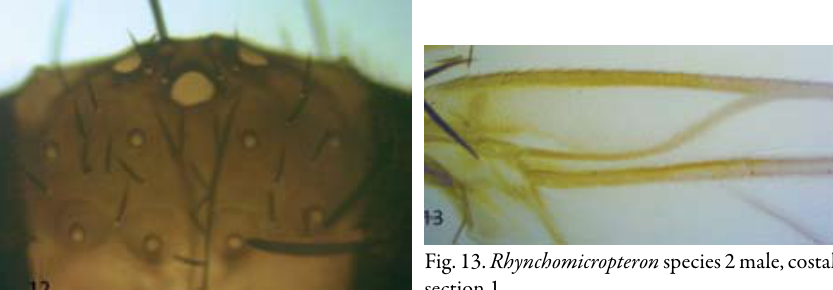
Fig. 13. Rhynchomicropteron species 2 male, costal section 1.